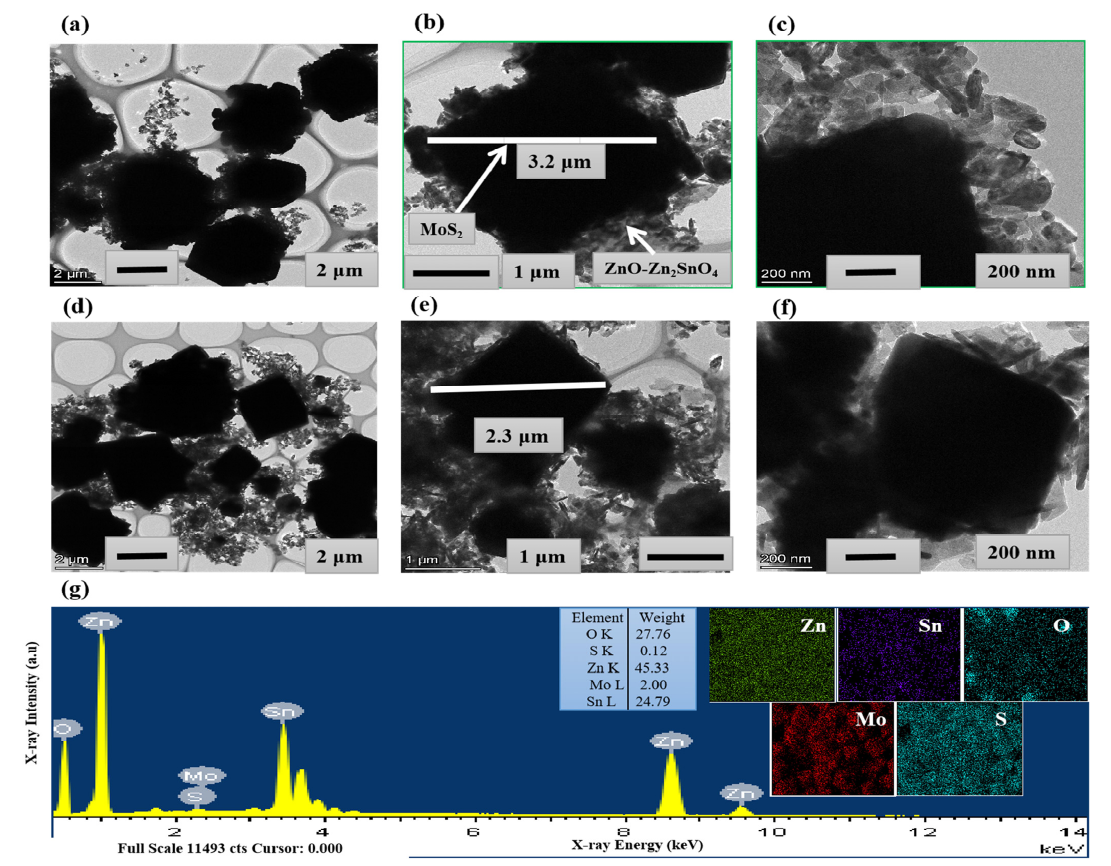
Figure 3. ( a – c ) TEM images of MS-ZNO-5; ( d – f ) TEM images of MS-ZNO-10; ( g ) EDS mapping and spectrum of all elements in MS-ZNO-5.